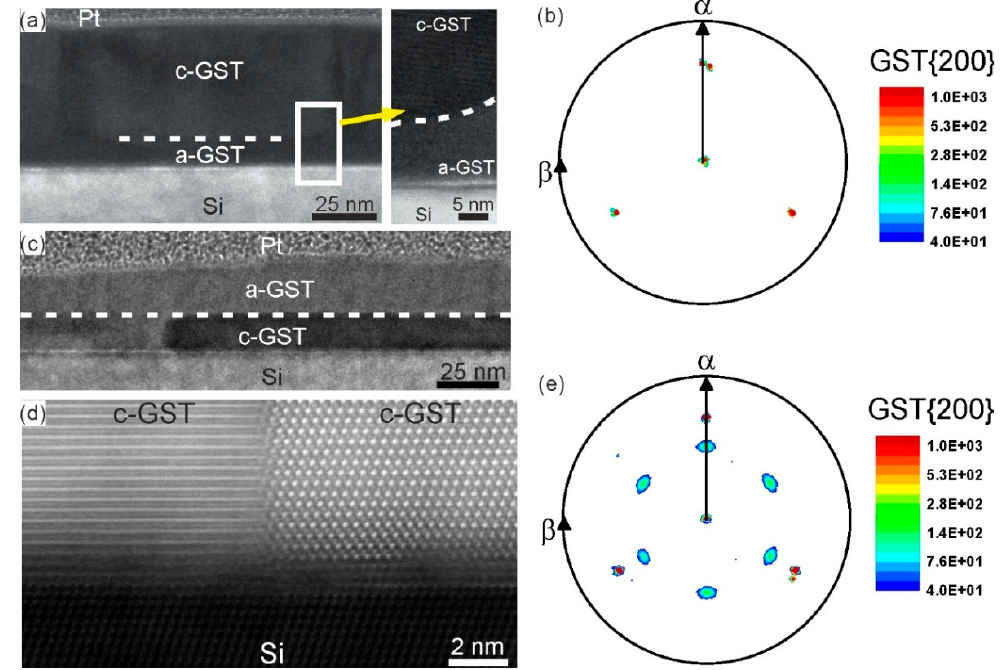
Figure 4. ( a ) BF-TEM image of a-GST thin film irradiated by a single ns-laser pulse with a fluence of 17 mJ / cm 2 . The interface between the crystalline and the amorphous region is indicated by a dashed line. ( b ) XRD pole figure of the c-GST {200} reflections exhibiting only the pole density maxima contributions from the Si substrate. ( c ) BF-TEM image of a-GST thin film irradiated by a single ns-laser pulse with a fluence of 26 mJ / cm 2 . A dashed line indicates the interface between the crystalline and the amorphous region. ( d ) HAADF-HRSTEM image of the GST-Si (111) interface formed during crystallization of a-GST. ( e ) XRD pole figure of the c-GST {200} reflections exhibiting contributions from both the epitaxially recrystallized GST film and the Si substrate.